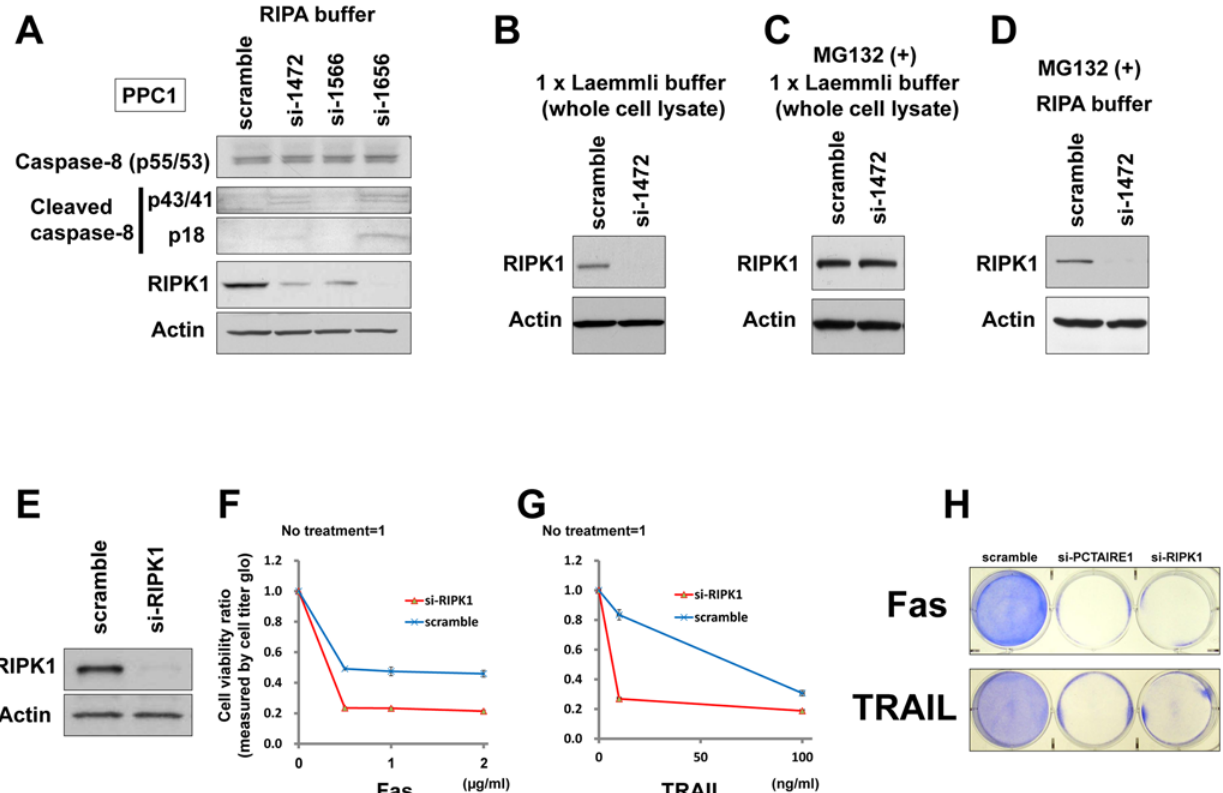
Fig 4. PCTAIRE1-knockdown modulates RIPK1 expression. (A) PPC1 cells were transfected with control RNA or three different siRNAs targeting PCTAIRE1. After 48 hours, cell lysates were prepared with RIPA buffer, normalized for total protein content, and analyzed by immunoblotting using the indicated antibodies. (B) PPC1 cells were transfected with indicated siRNAs for 48 hours, whereupon cell lysates were collected in 1x Laemmli buffer and subjected to immunoblotting analysis for RIPK1 (top) and beta-actin (middle). (C, D) PPC1 cells were transfected with the indicated siRNAs. After 48 hours, cells were treated with the proteasome inhibitor MG-132 (10 μ M) for 5 hours before preparation of cell lysates (C: 1x Laemmli buffer, D: RIPA buffer). (E) PPC1 cells were transfected with control RNA or siRNA targeting RIPK1. After 48 hours, cell lysates were prepared in RIPA buffer, normalized for total protein content, and analyzed by immunoblotting using the indicated antibodies. (F, G) PPC1 cells were transfected with control RNA or siRNA targeting RIPK1. After 48 hours, cells were stimulated with either anti-Fas antibody (CH-11) (F) or TRAIL (G) at various concentrations as indicated. After 24 hours, cellular ATP levels were measured as a surrogate indicator of cell viability using Cell Titer Glo reagents, and the data expressed as a ratio between cells cultured with and without anti-Fas (F) or TRAIL (G). (H) Clonogenic survival assays. PPC1 cells were seeded in 6 well (35 mm) dishes at 1.0 x 10 5 cells per well, and then reverse-transfected with scramble-control, PCTAIRE1-targeting siRNA (si-1472), or RIPK1-targeting siRNA as indicated. After 48 hours, anti- Fas antibody (top, 2.5 ng/ml) or TRAIL (bottom, 10 ng/ml) was added and cells were cultured for 3 days before fixing and staining with 0.5% crystal violet dye.